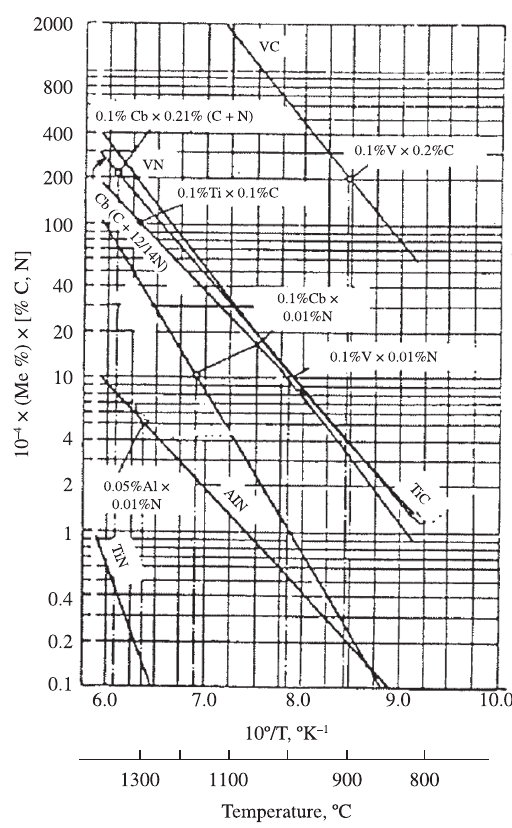
Figure 2. Solubility products of niobium, aluminium, vanadium and titanium nitrides and carbides 4 .